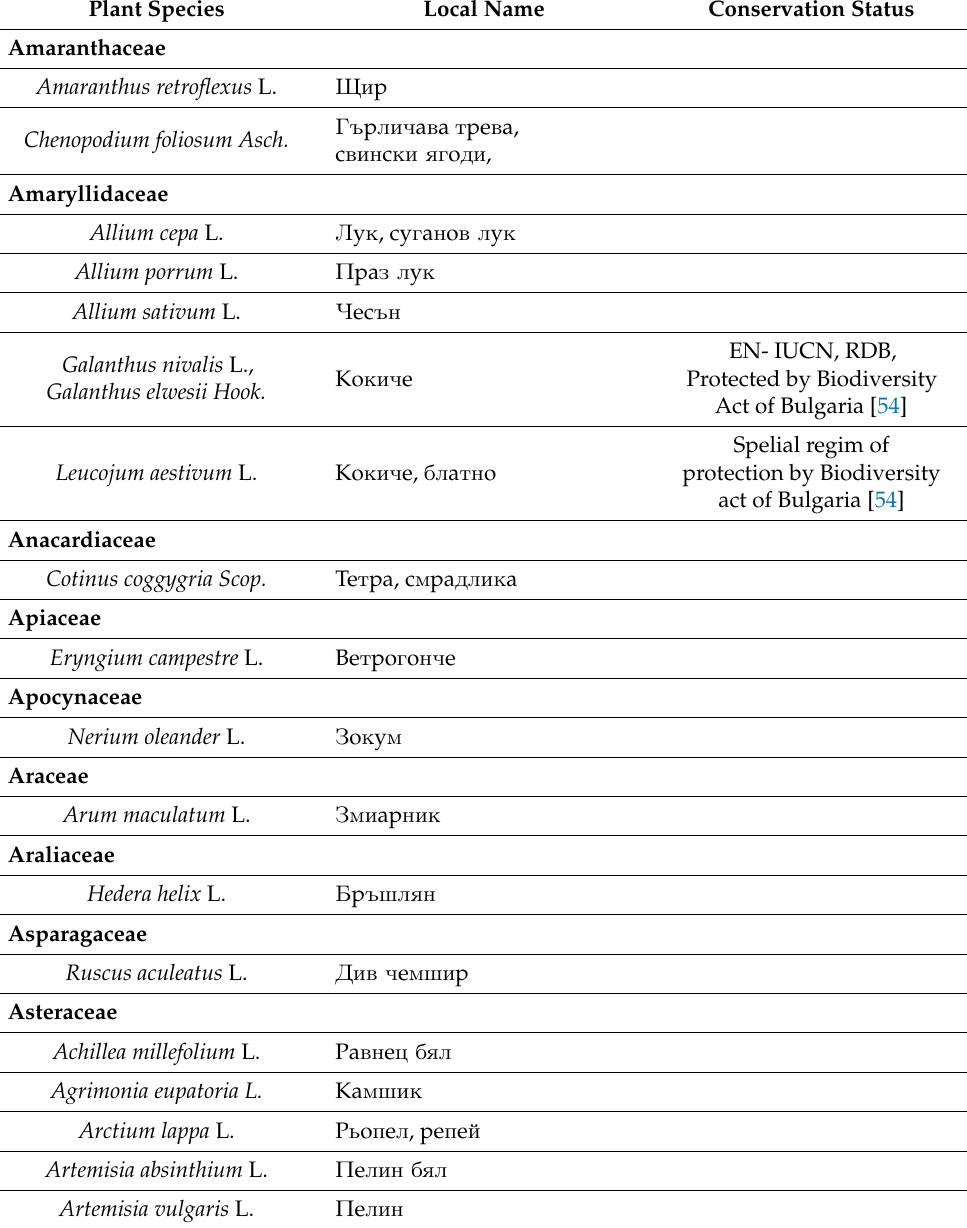
Table 1. Plants used in the Central and East Rhodopes legend: Special regime of collection (MOEW)— Ministry of Environment and Waters restricts collection quota each year, Bal. Balkan Endemic, RDB-Red Data Book of